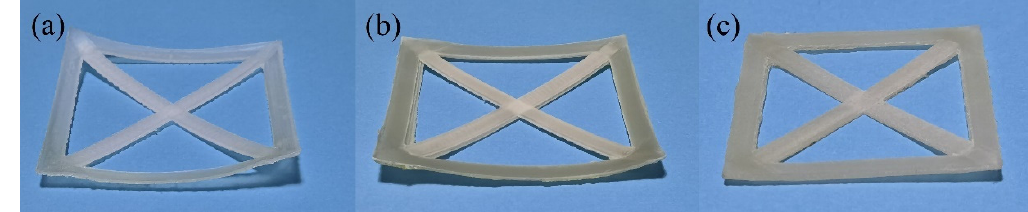
Figure 4. Photos of selected samples for warpage analysis: ( a ) S-PPR; ( b ) S-1; ( c ) S-3.